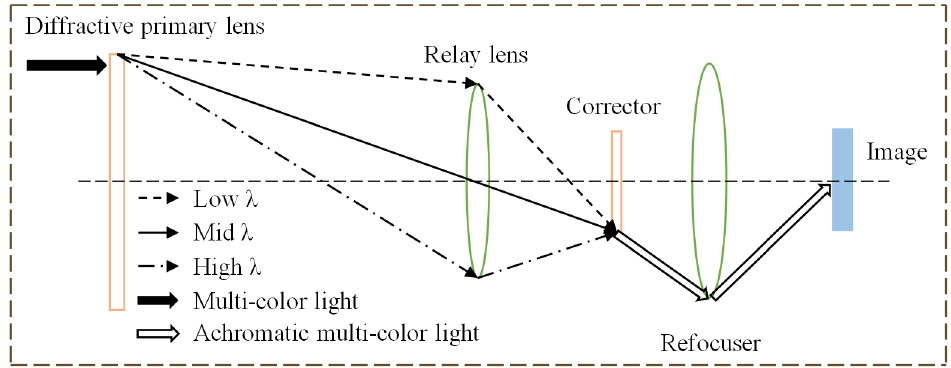
Figure 1. Schematic diagram of Schupmann achromatic structure.